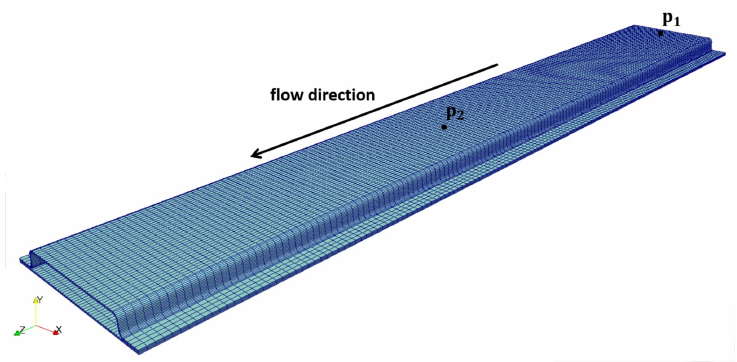
Figure 13. Simulation model of the sandwich part with the main flow direction and the location of two pressure